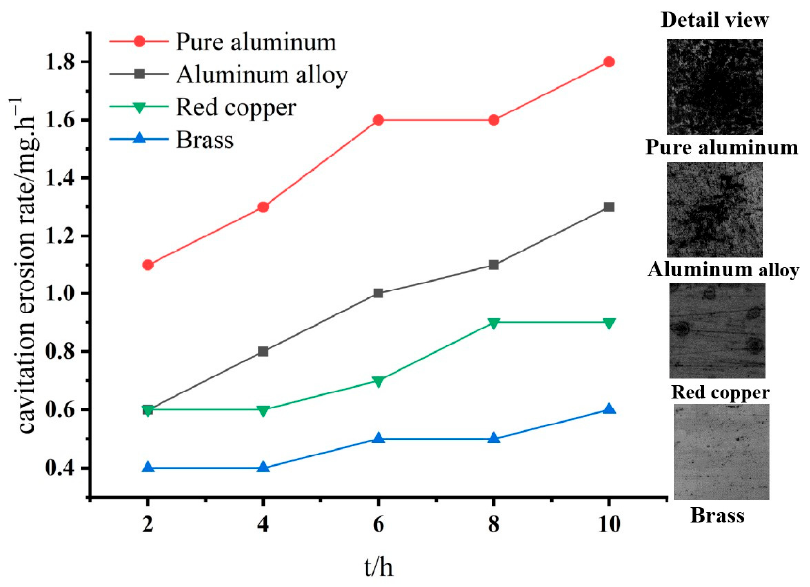
Figure 5. The cavitation erosion rate of different metallic materials samples vs. acting time.